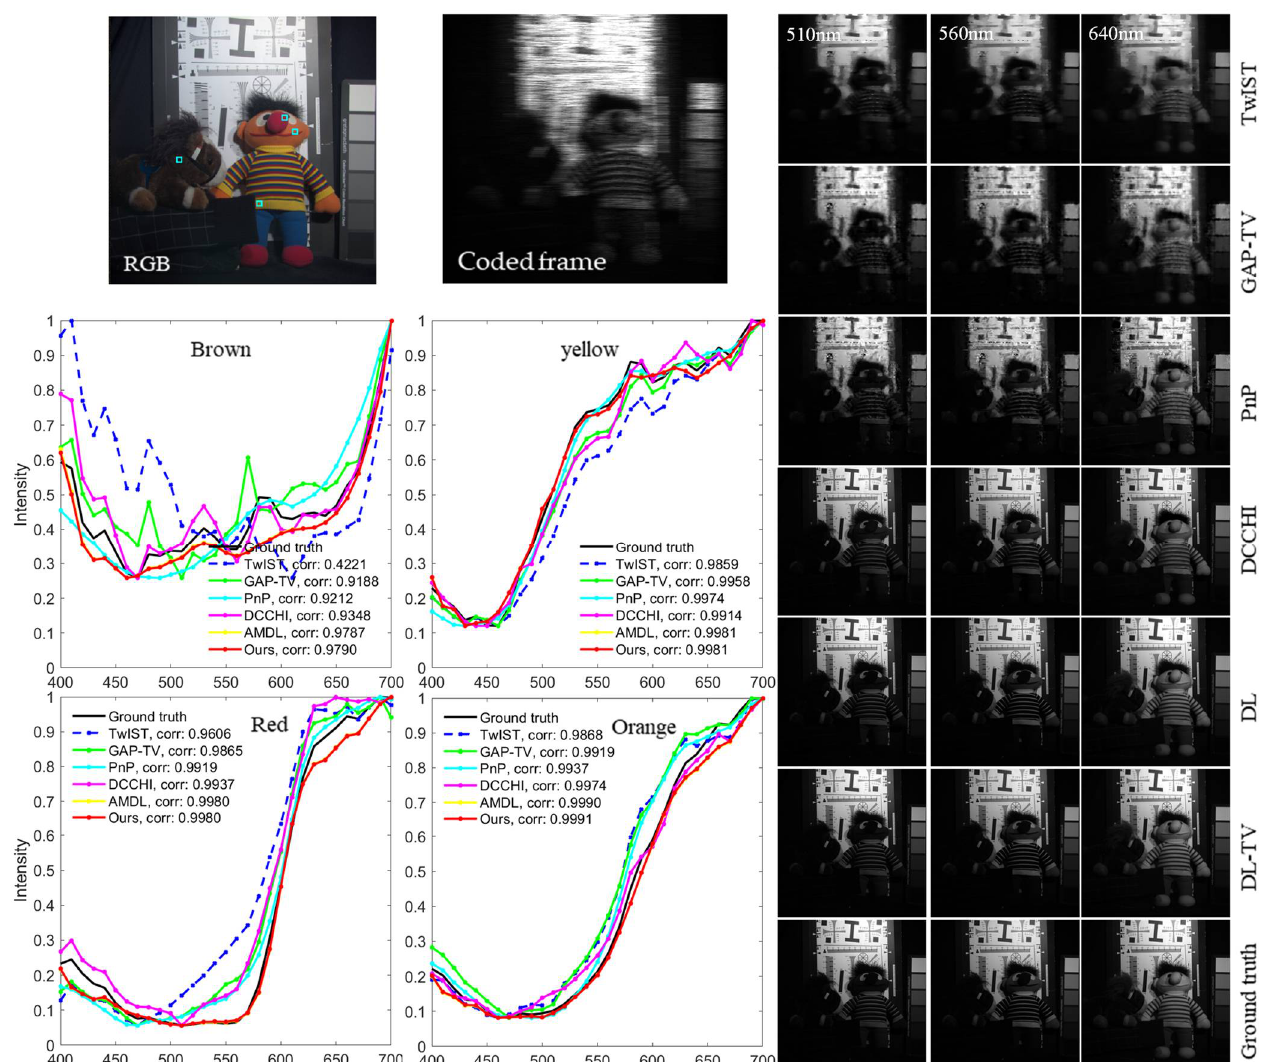
Figure 4. Reconstruction spectra of “toy” MSI of the CAVE dataset. The original RGB image and the coded frame of the scene are shown at the top. The spectra of four color regions are shown on the left. The three reconstructed frames at wavelengths 510, 560, and 640 nm are shown on the right.